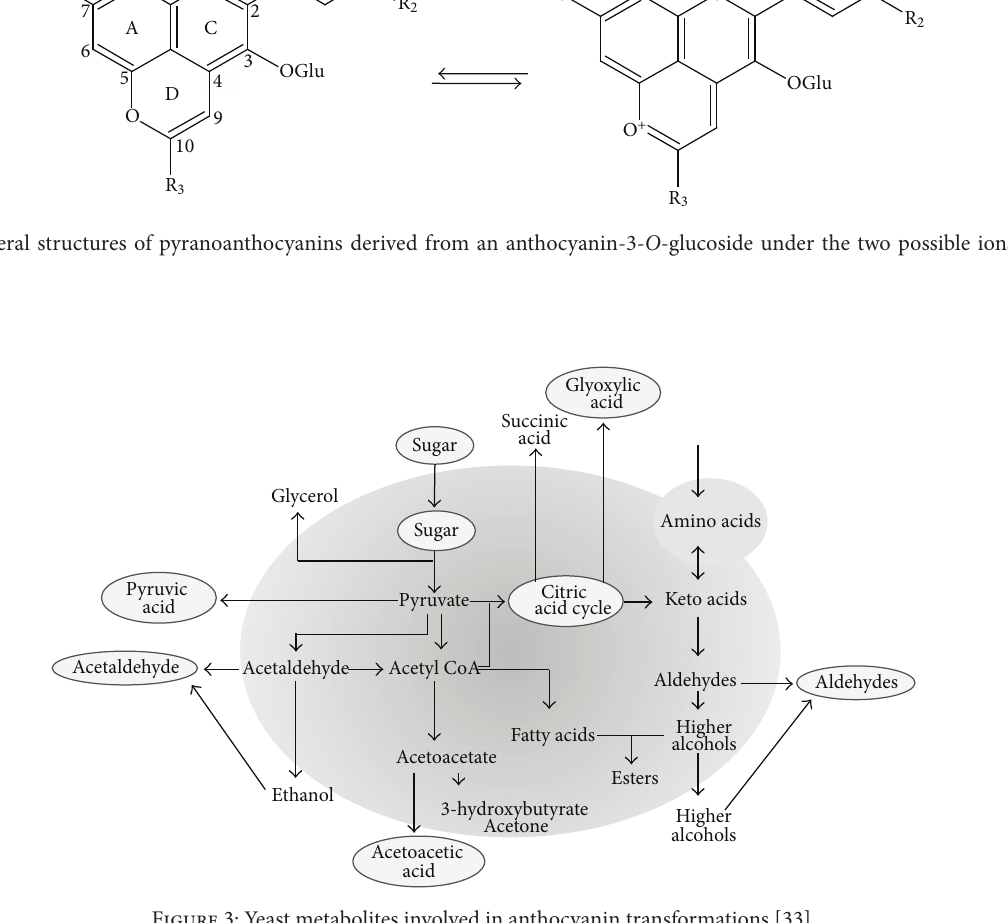
F 3: Yeast metabolites involved in anthocyanin transformations